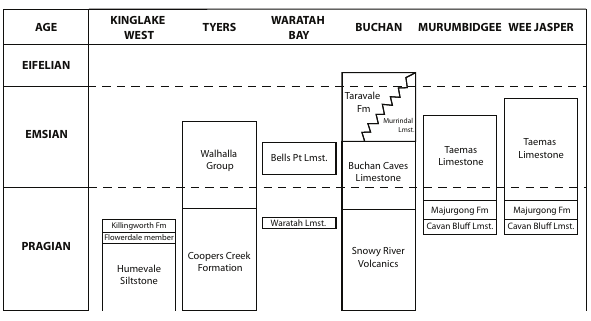
Fig. 8. Generalised correlation column of stratigraphy in Victo- ria and southern New South Wales. Description of regions were based on formations described in Webby (1972) and Philip and Pedder (1967). Adjustments were made to the temporal range of the Buchan Caves Limestone (Holloway, 1996) and Coopers Creek Formation (Rehfisch and Webb,